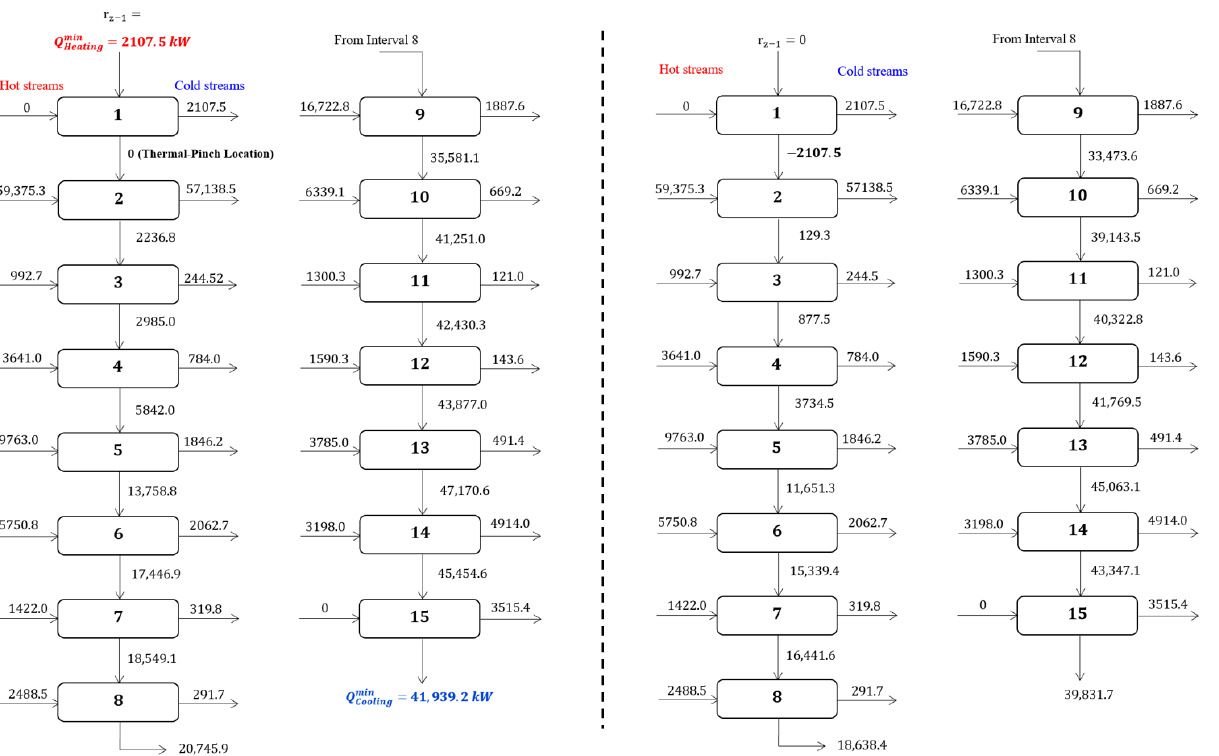
Figure 6. Cascade diagram ( left side ) and revised cascade diagram ( right side ).